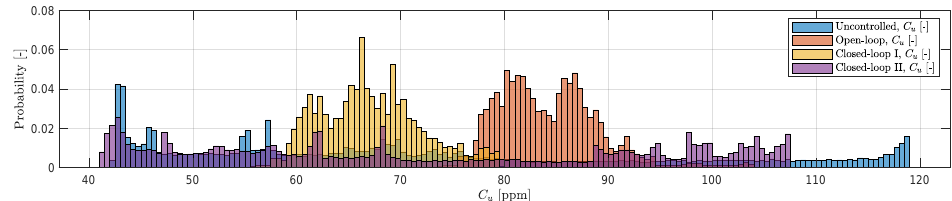
Figure 14. Underflow OiW concentration distributions of the four